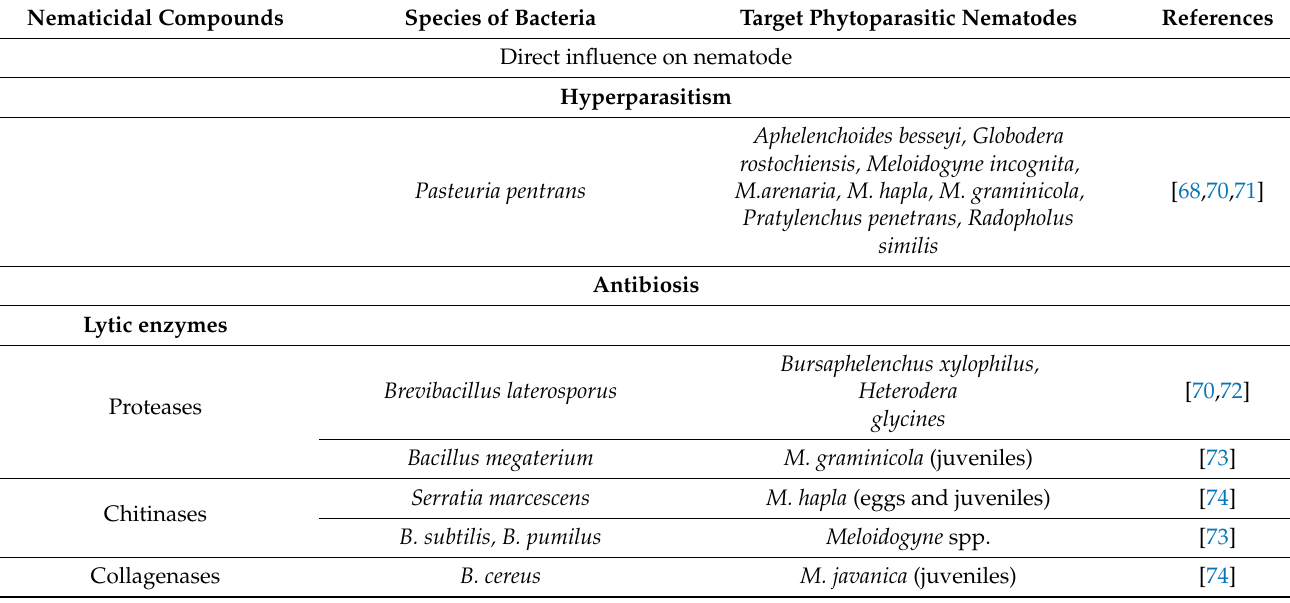
Table 1. Bacteria and their modes of action against phytoparasitic nematodes. Nematicidal